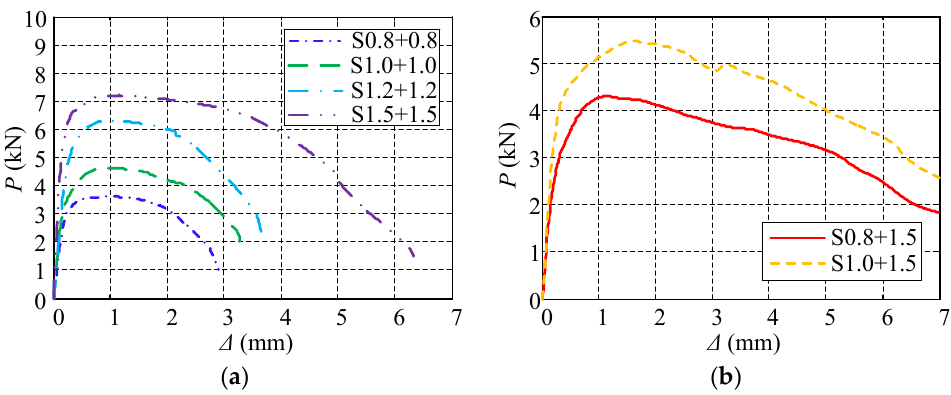
Figure 6. Load–relative displacement curves: ( a ) failure mode I, ( b ) failure mode II.